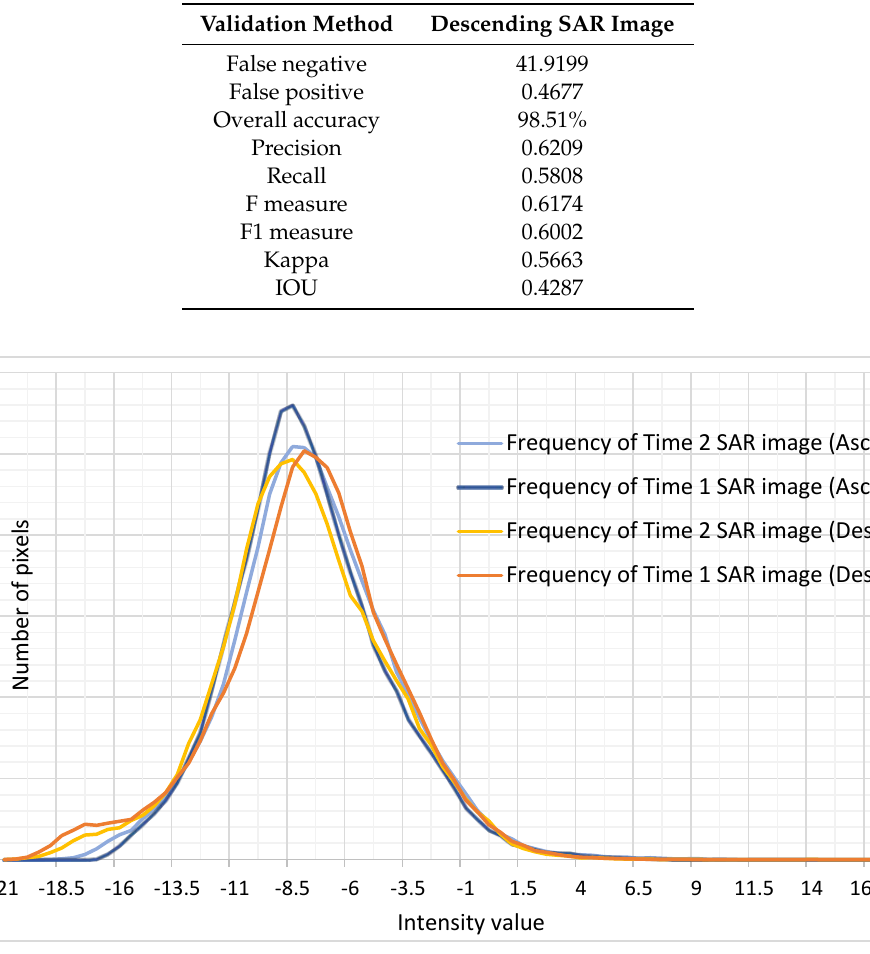
Figure 16. Histogram of Time 1 and Time 2 ascending and descending SAR images (the dates of acquiring the Time 1 and Time 2 ascending image pair are 10 January 2008/15 January 2010, and the dates of acquiring the Time 1 and Time 2 descending image pair are 18 September 2008/9 August 2010).